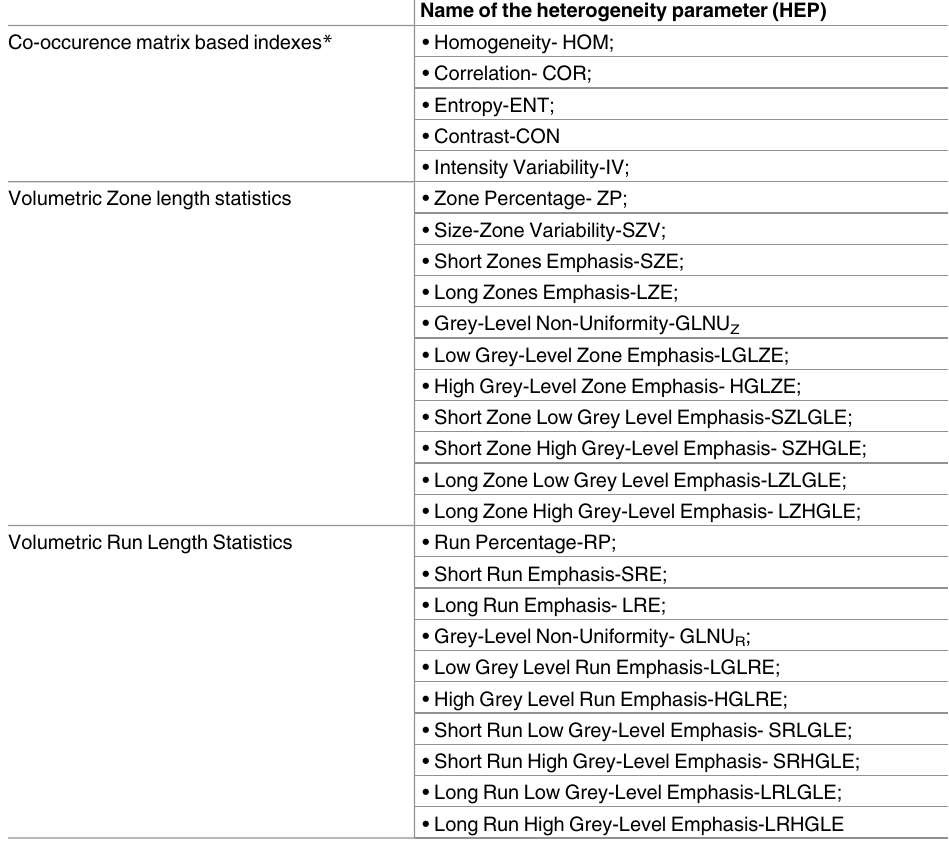
Table 2. List of Indices Calculated from Texture Matrices, followed by the short name.